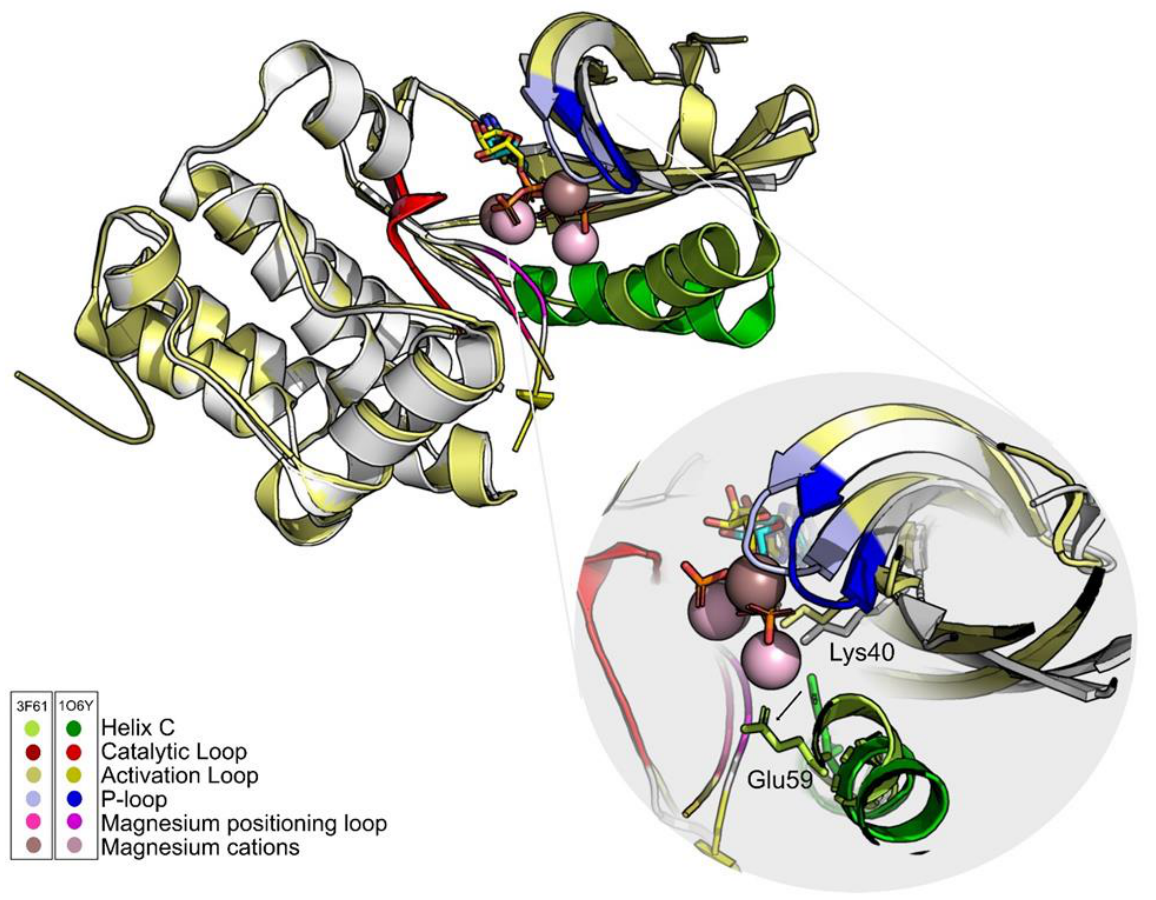
Figure 4. The ATP analogs are shown in cyan (1O6Y) and yellow (3F61) sticks. Differences in the position of the main PknB groups are highlighted. One of the fundamental differences between structures is the position of Glu59. In 3F61, this residue shifts away from the active site and the hydrogen bond with Lys40 does not occur. The only group that maintains its positions in both structures is the catalytic loop (red). Figure was produced using Pymol.